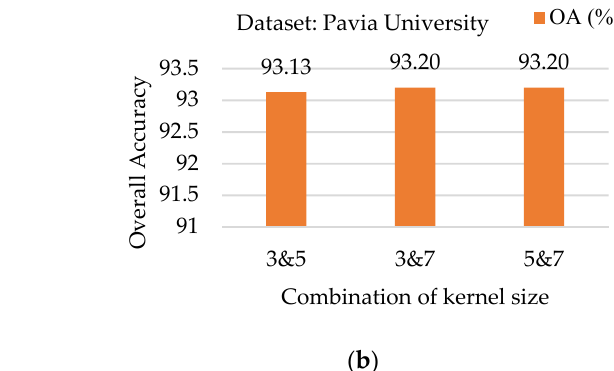
Figure 9. Accuracy of different combinations of convolution kernels in the FsSE module for both datasets. ( a ) The result of the Indian Pines dataset; ( b ) The result of the Pavia University dataset. Table 1. Training time and number of parameters required for three different combinations of con- volutional kernel sizes on the Pavia University dataset.